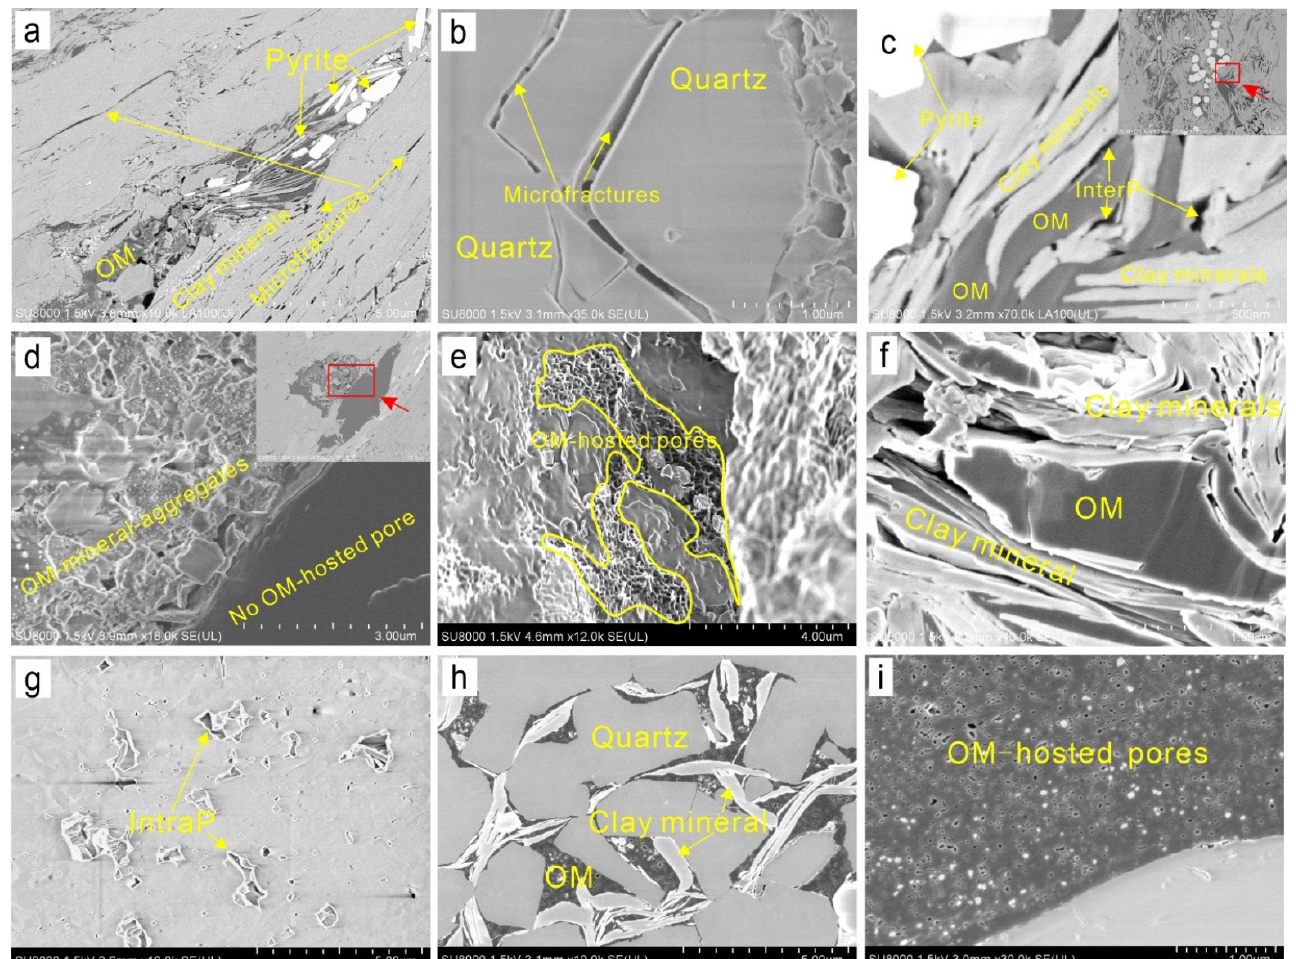
Figure 5. FE-SEM photomicrograph images of the studied shale samples. ( a – c ): sample YC2-6, BSE model; ( d – g ): sample YC2-7; ( d ): BSE model; ( e – g ): SE model; ( h , i ): sample YC9-1, SE model. ( a ): Orientation and deformation of minerals resulted from intense compression, forming interlayer pores and microfractures in clay minerals. ( b ): Fractures within a single quartz particle. ( c ): InterP pores between clay and OM, formed by deformation. ( d ): Irregular pores occurring within OM– mineral aggregates, but rare pores occurring within OM. ( e ): OM–mineral aggregates with reticular pores. ( f ): OM between clay minerals, without pores, and interP pores between clay minerals, which may be caused by deformation. ( g ): Dissolution pores in carbonate minerals. ( h , i ): OM with a large number of circular and elliptic pores.